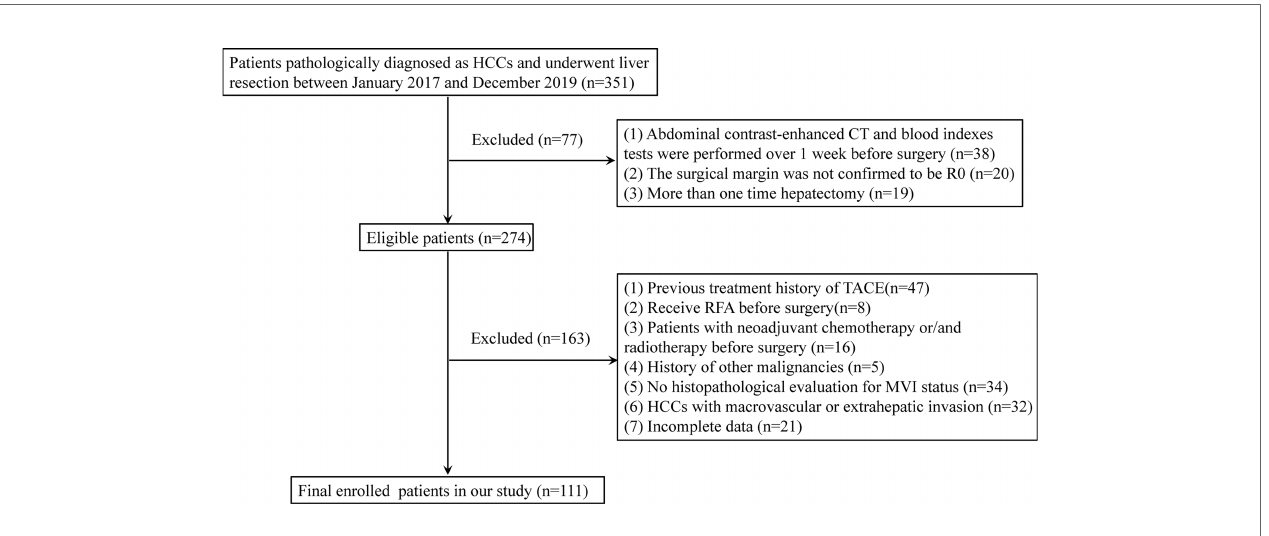
FIGURE 1 | Flowchart of the patients included in the